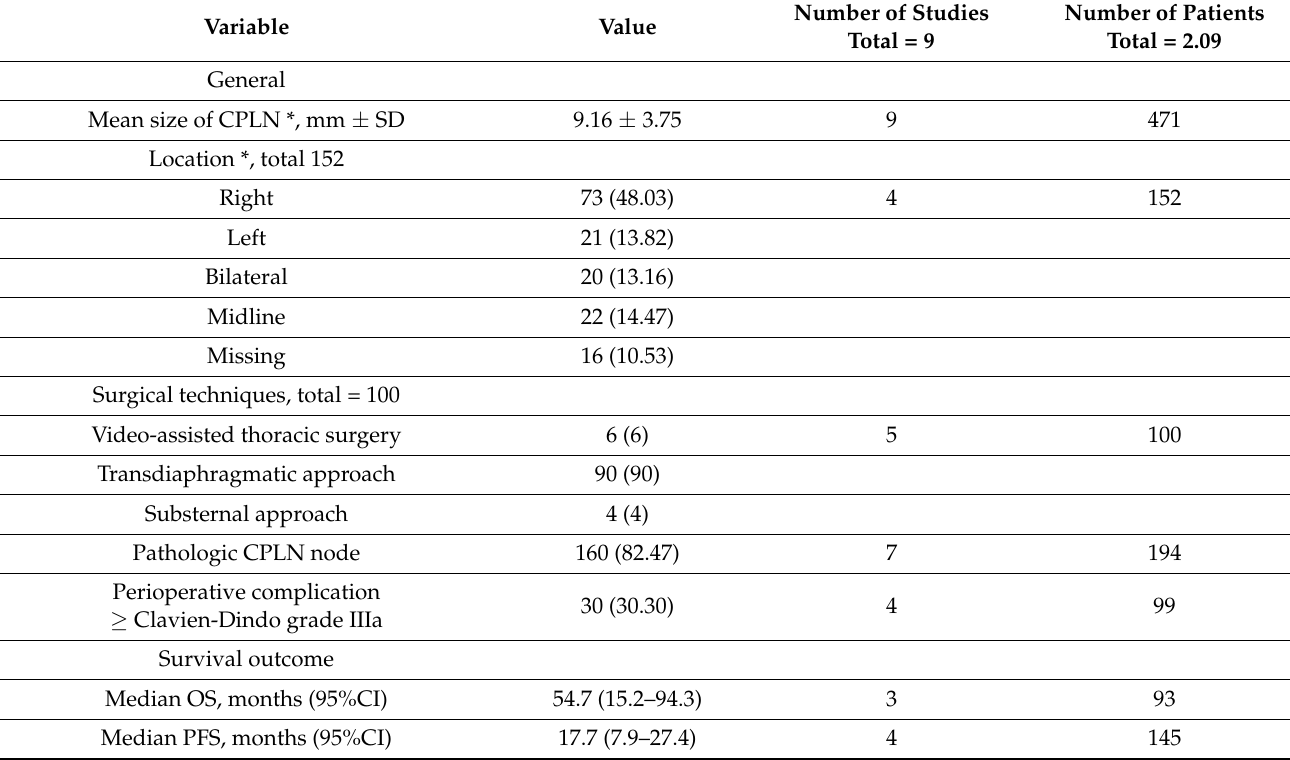
Table 2. Pooled baseline characteristic of patients who underwent CPLN